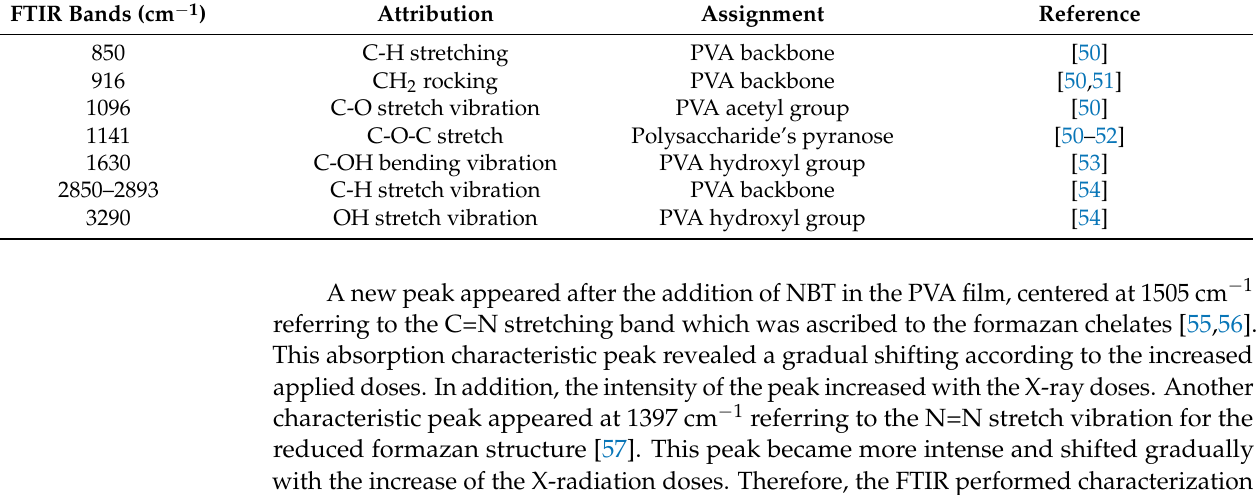
Figure 5. FTIR spectra of PVA film ( a ), unirradiated PVA/NBT film ( b ) and the X-irradiated PVA/NBT films receiving different doses; 4 mGy ( c ), 10 mGy ( d ) and 20 mGy ( e ).